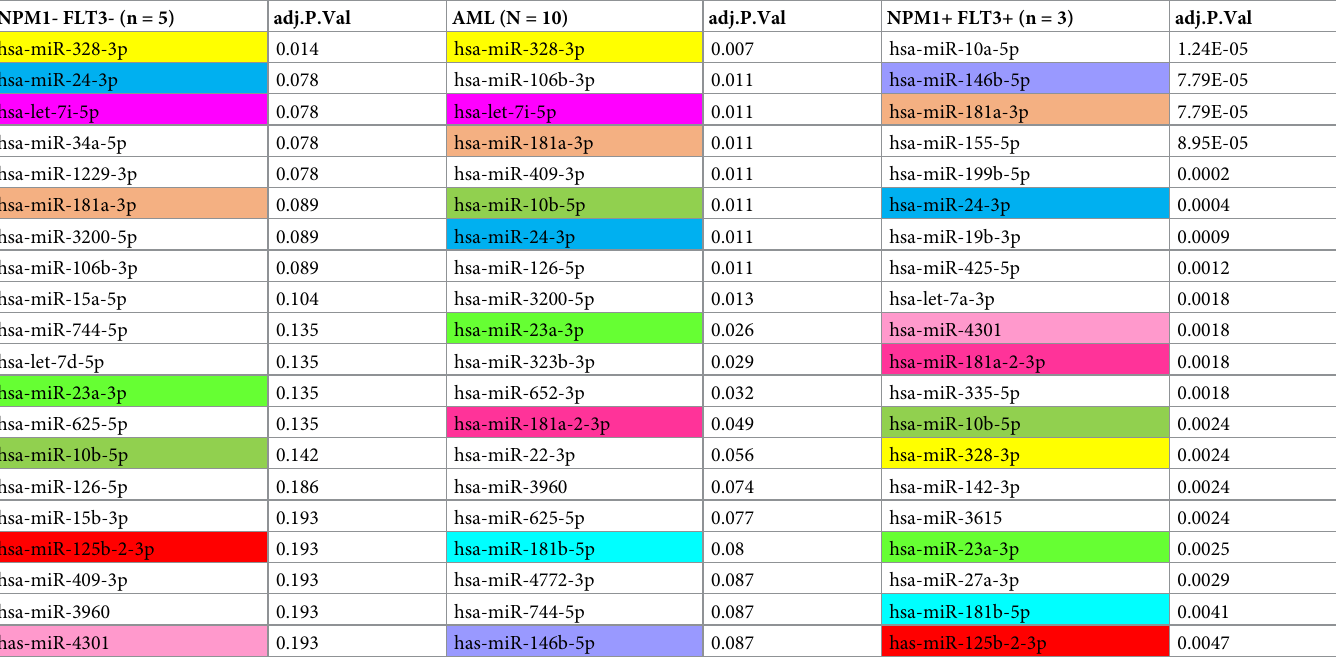
Table 2. Differential expression of miRNAs in patients versus controls ranked by adjusted